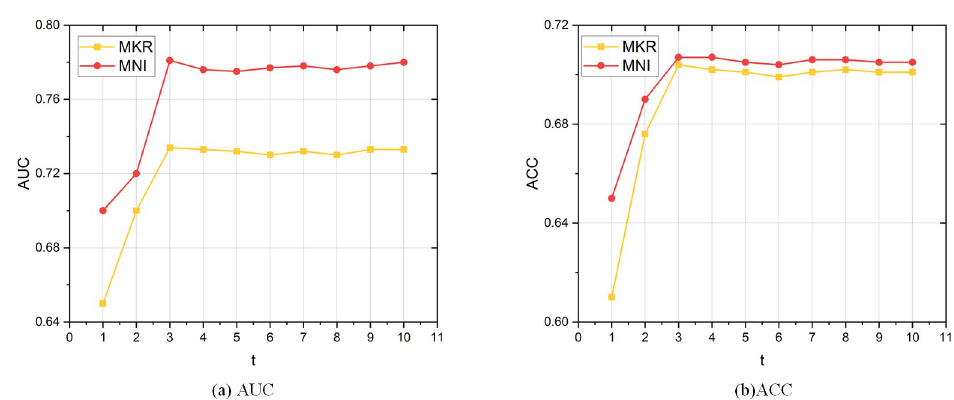
Fig 8. Training frequency on book-crossing.